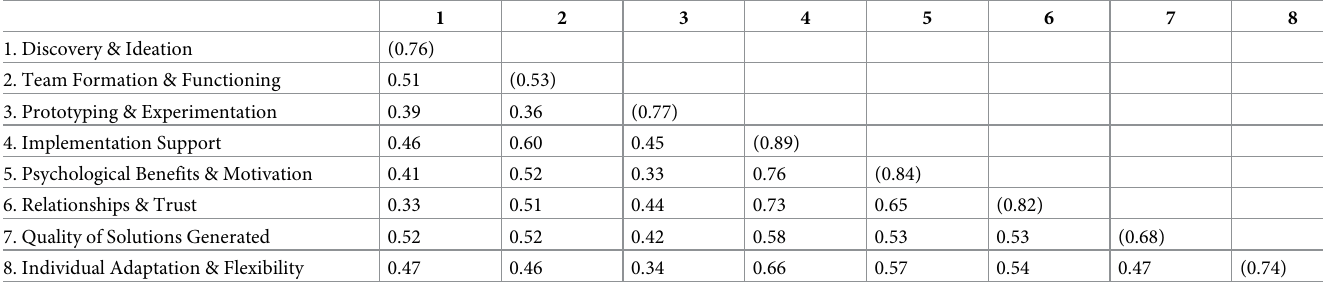
Table 6. Bivariate correlations (r p ) and reliabilities ( α , in parentheses) for DT